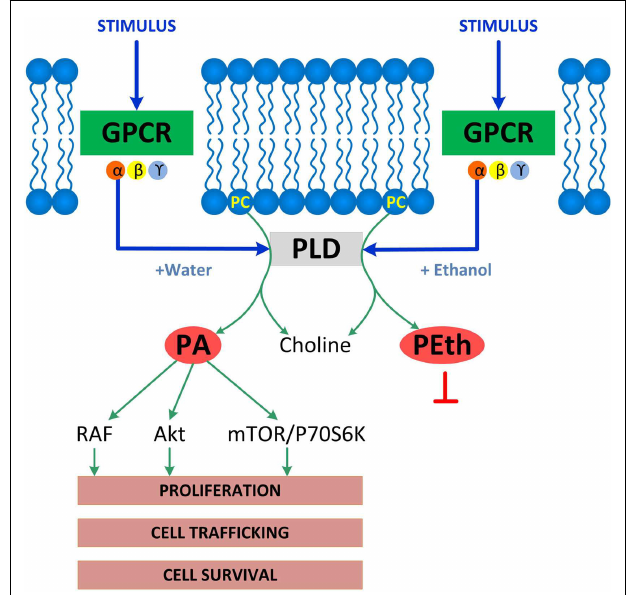
FIGURE 1 | Enzymatic reactions catalyzed by PLD . PLD is associated with membrane receptors including G-protein coupled receptors (GPCR), receptor tyrosine kinases, or integrins, which all activate PLD. Shown is GPCR-coupled PLD, which, upon activation under physiological conditions, hydrolyzes phosphatidylcholine (PC) to produce choline and phosphatidic acid (PA), a lipid second messenger that binds and activates several signaling molecules including RAF, Akt, mTOR, and p70S6K and stimulates several cell functions including proliferation, cell trafficking, and cell survival. The PLD signaling pathway is disrupted by ethanol, which competes with water leading to the formation of phosphatidylethanol (PEth) at the expenses of phosphatidic acid, therefore, inhibiting phosphatidic acid-activated signaling and